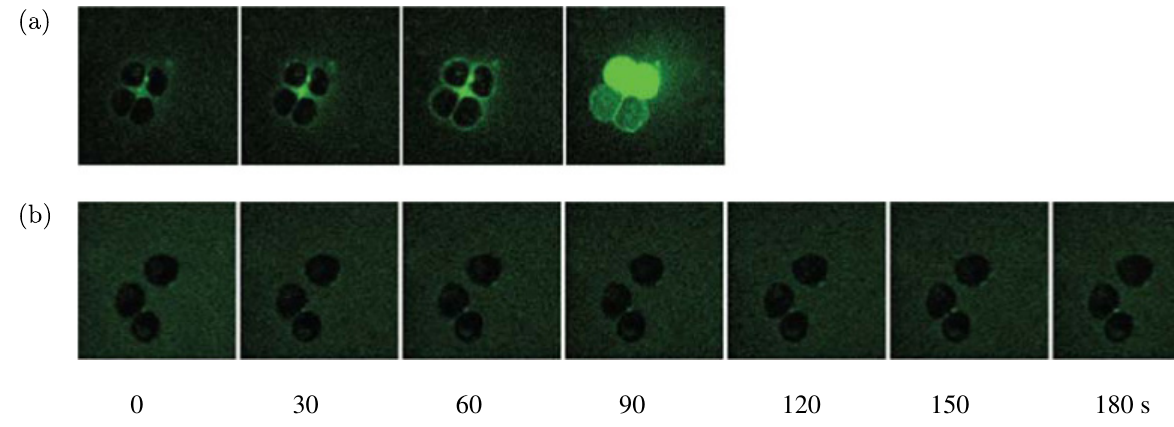
Fig. 3. CNE2 cells were incubated with: (a) 4 (cid:1) M PpIX for 1 h and (b) 100 (cid:1) M TMPyP for 6 h, respectively. The confocal images of SOSG were acquired at various time points after continuous irradiation with 633 nm